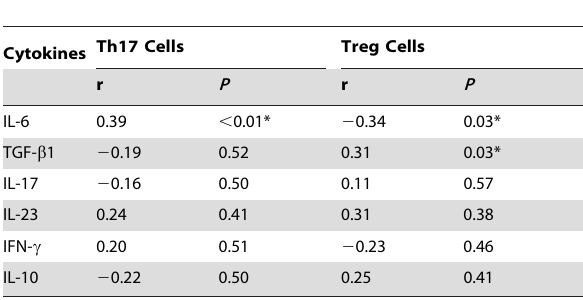
Table 2. The correlation of Th17 and Treg cells with serum cytokines in patients with ACS.